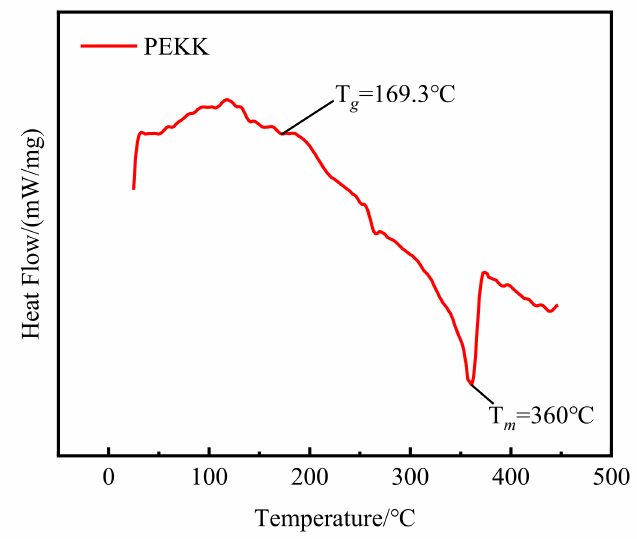
Figure 2. DSC curves of PEKK in the